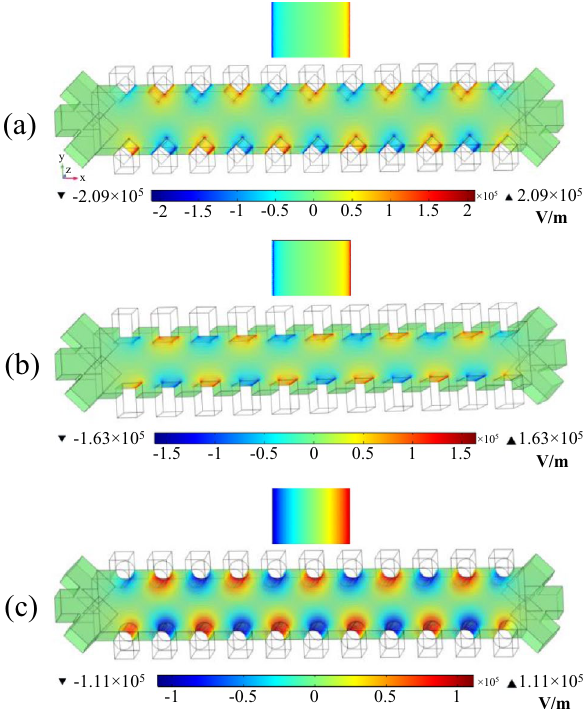
Figure 8. Distribution of the electric field for various electrode configurations ( a ) triangular ( b ) rectangular ( c ) semi-circular.